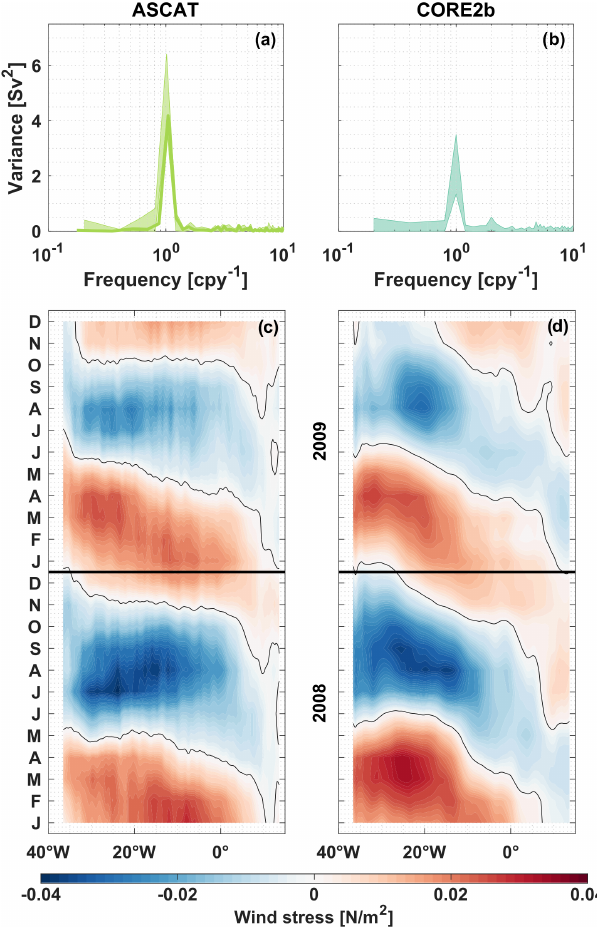
Figure 7. Periodograms of the Ekman transport at 11 ◦ S, derived from ASCAT (a) and INALT01 (b) wind stress. The bold curve in panel (a) is calculated for the period 2013–2018. Transparent en- velopes in panels (a–b) give an estimate of interannual variations: specifically, the minimum and maximum ranges of periodograms calculated for 5-year windows running through the full available time series of ASCAT (2008–2018) and INALT01 (1978–2009). Frequency is given in “cycles per year”. Hovmöller diagrams of the ASCAT (c) and INALT01 (d) zonal wind stress anomalies along 11 ◦ S for the overlapping years (2008–2009). Red (blue) colours in (c–d) imply eastward (westward) wind stress anomalies.